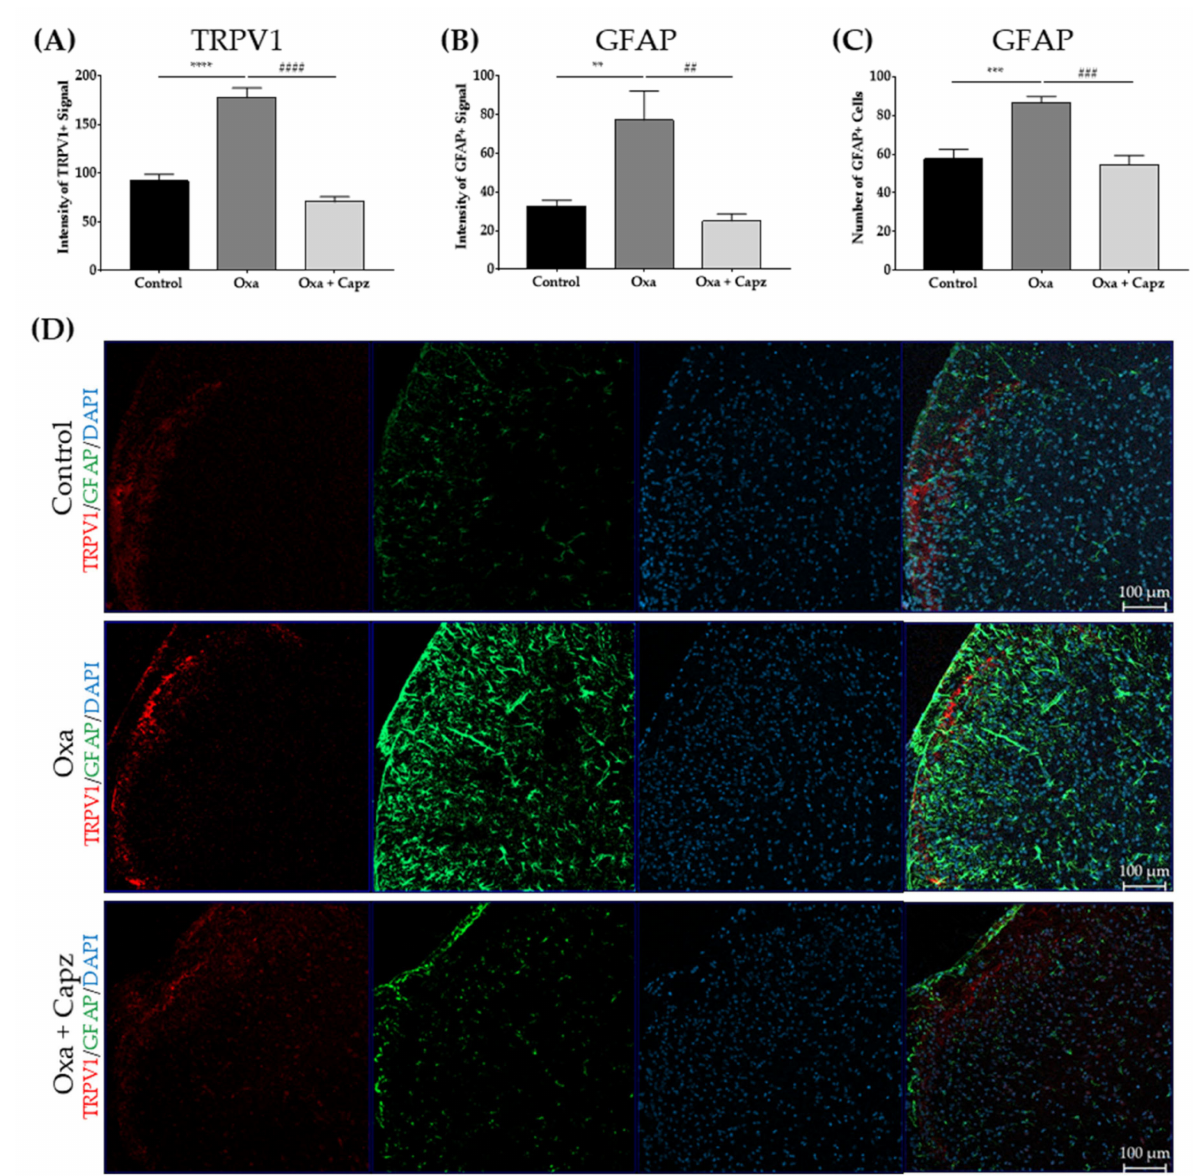
Figure 4. Effects of TRPV1 antagonist on spinal GFAP and TRPV1 levels. On D4 after oxaliplatin injection, spinal TRPV1 and GFAP levels were observed and evaluated. In the oxaliplatin group (Oxa), an increase in spinal TRPV1 and GFAP signal intensity ( A , B ) and in the number of GFAP positive cells ( C ) were observed. These increases in TRPV1 and GFAP signals were downregulated 2 h after capsazepine (Capz) treatment (10 µ g). Naïve mice were used as a control group ( A , B ). Intrathecal injection of 20% DMSO was conducted on the Oxa group as a control for Capz. Representative images from each group are presented. The fourth image in each row represents the merge of the three images on the left ( D ). Control: n = 6, Oxa: n = 6, Oxa + Capz: n = 6. ** p < 0.01, *** p < 0.001, **** p < 0.0001 vs. control, ## p < 0.01, ### p < 0.001. #### p < 0.0001 vs. Oxa with one-way ANOVA followed by Tukey’s post-test for multiple